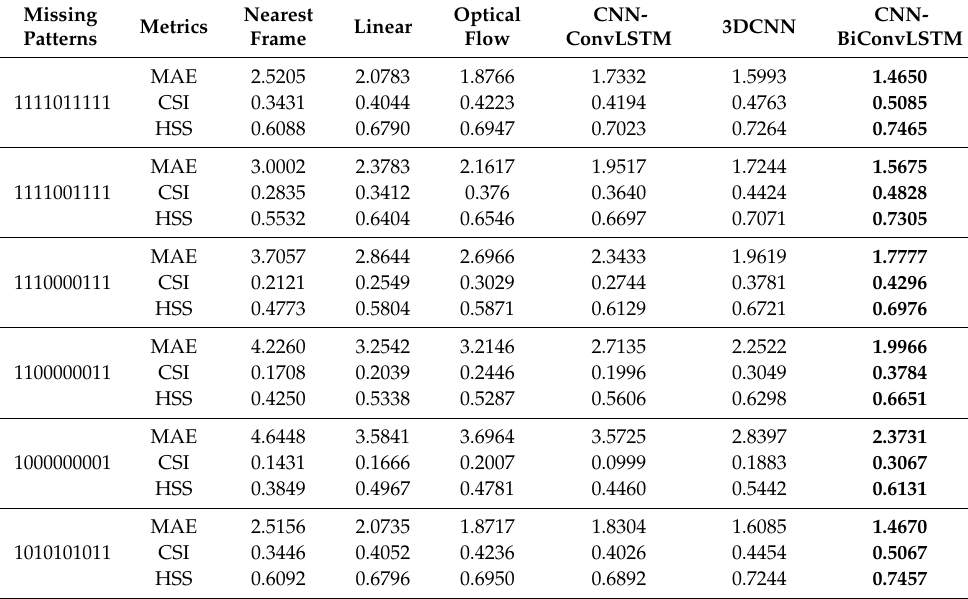
Table 1. Evaluation results of mean absolute error (MAE), Critical success index (CSI)-40 scores, and Heidke skill score (HSS) scores for the bi-directional convolutional long short-term memory networks (CNN-BiConvLSTM) model and baseline models and for 6 missing patterns with respect to